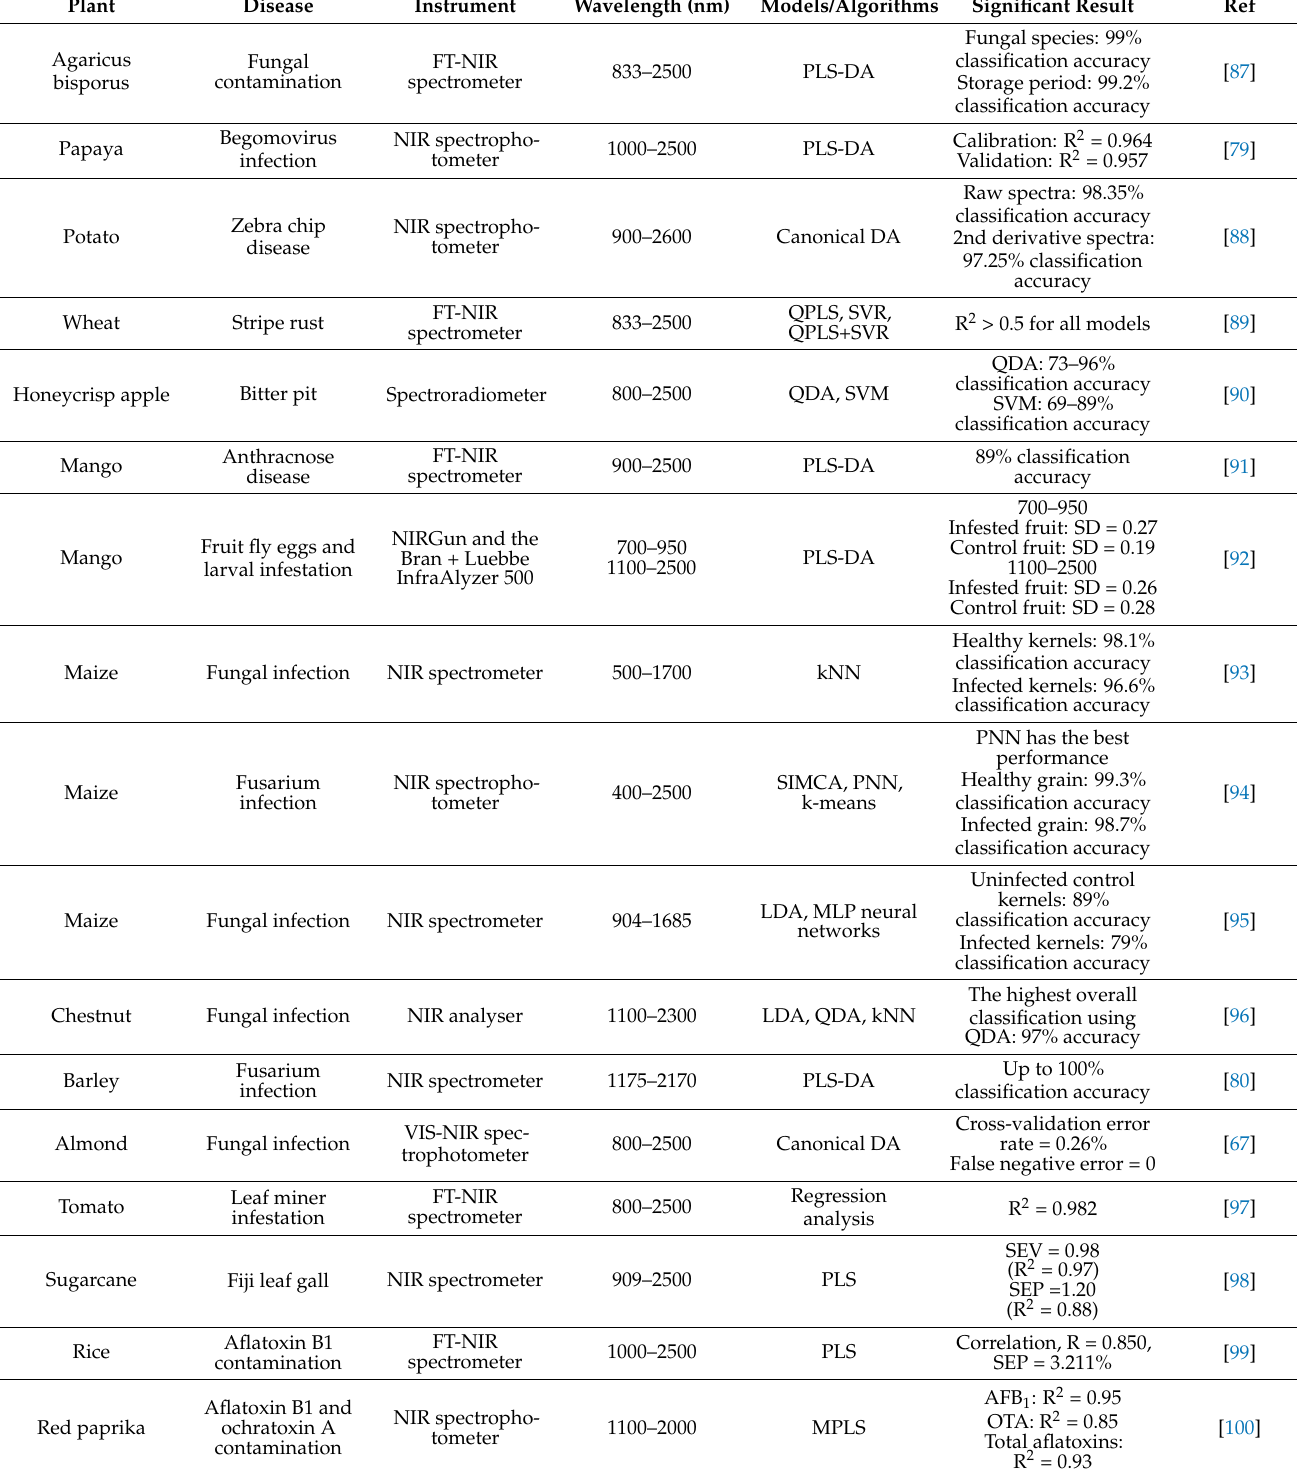
Table 5. Previous studies on plant disease detection using